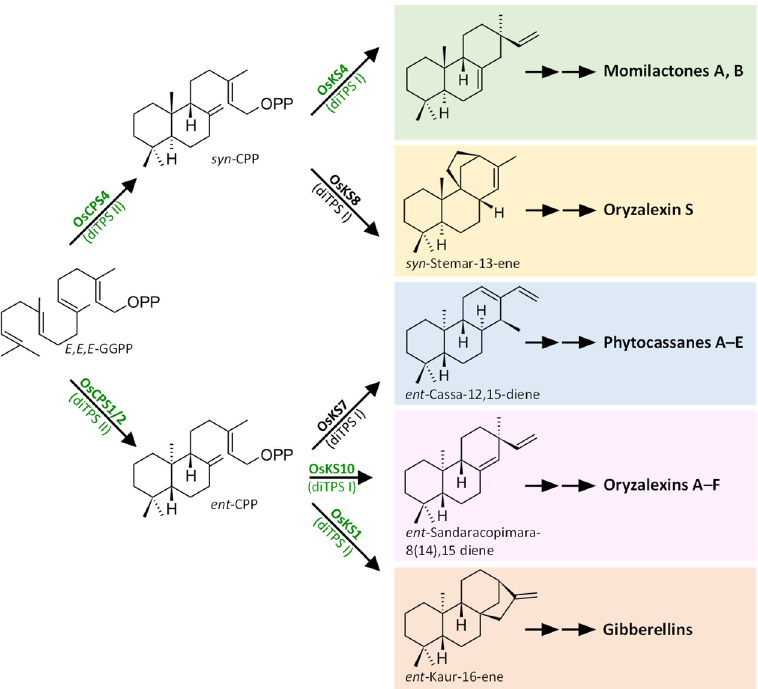
Figure 6. Proposed pathway for the biosynthesis of rice diterpenoid phytoalexins and gibberellins. The enzymes whose chloroplast localization is established are written in green. CPP: copalyl di-